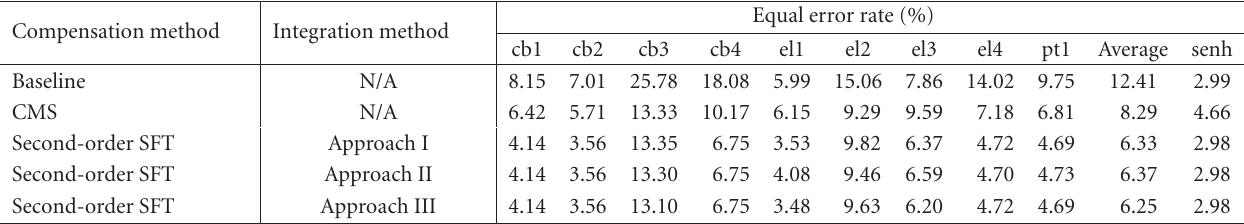
Table 5: Results for seen and unseen handsets with similar characteristics. Equal error rates (%) are achieved by the baseline, CMS, and the three handset selector integration approaches shown in Table 3, with handsets cb3 and el2 being used as the unseen handsets. The enrollment handset is senh. The average handset identification accuracy is 98.38%. Note that the baseline and CMS do not require the handset selector. Second-order SFT stands for second-order stochastic